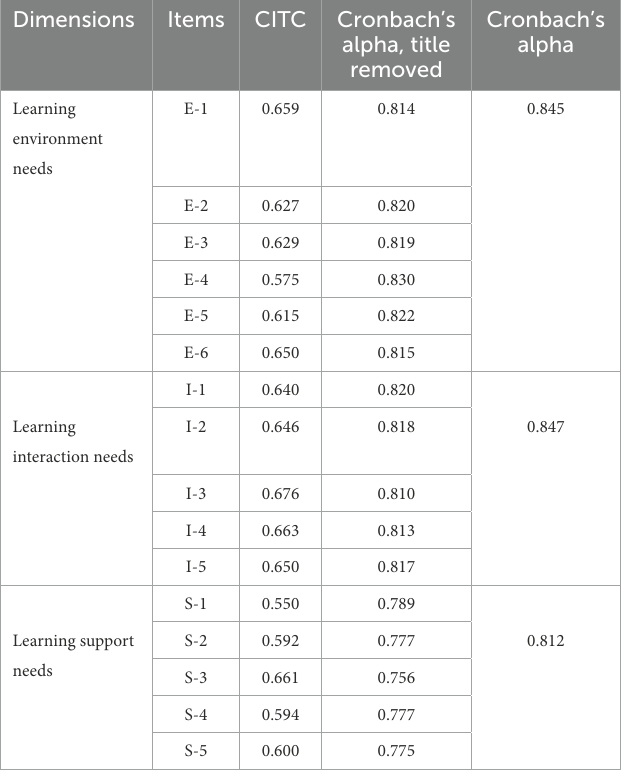
TABLE 3 Learning needs scale reliability checklist.